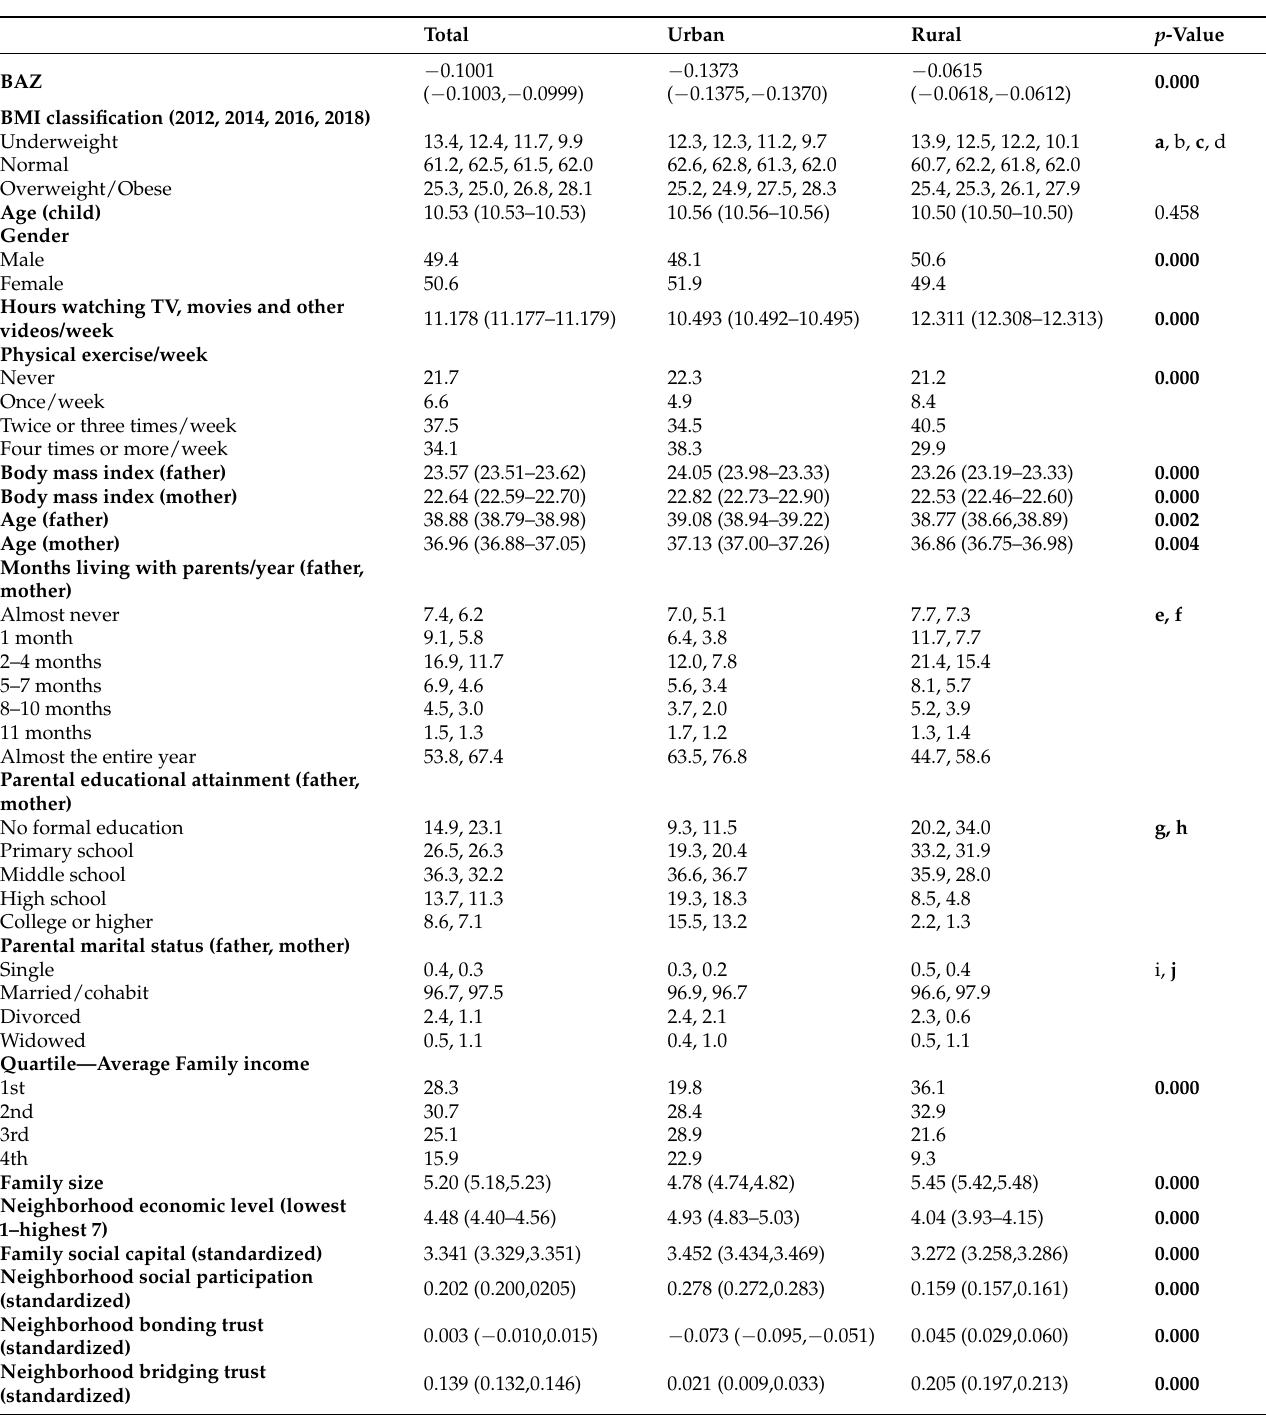
Table 1. Descriptive statistics of the total, urban and rural child participants across survey waves (cross-sectional data, %, mean (CI)). Total Urban